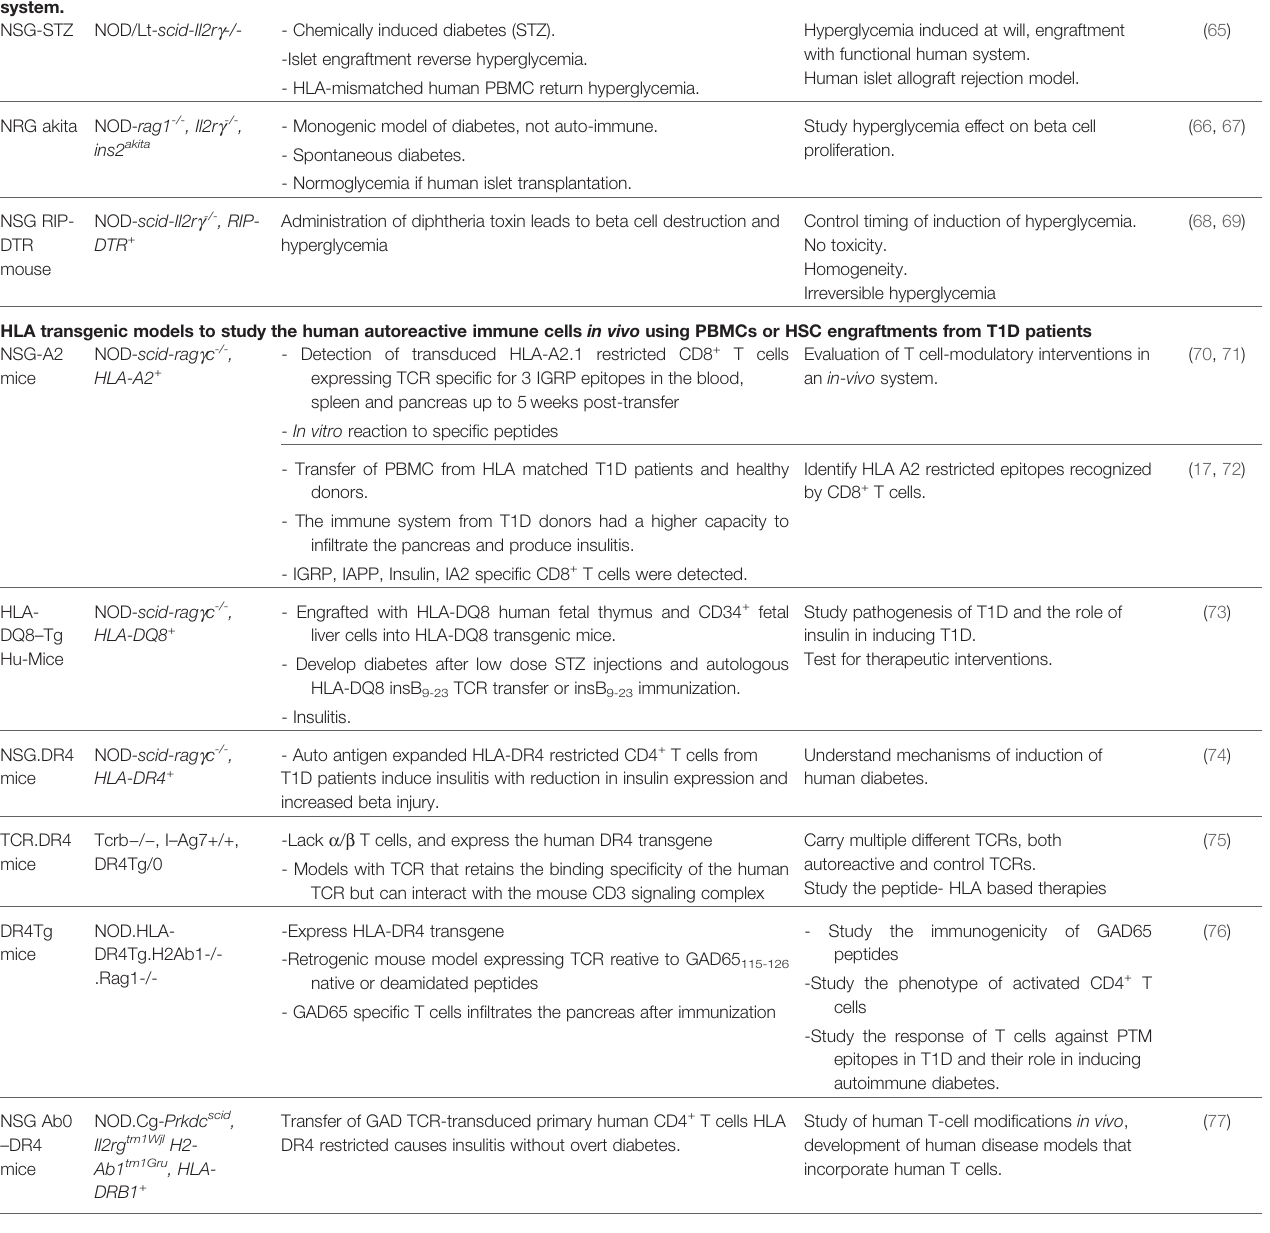
and dissect the role of islet autoantigens in T1D. A mouse model can be engrafted by human or murine stem cells transduced to express autoantigen-speci fi c TCRs to create retrogenic humanized models. The retrogenic mouse model allows to study human selection (82). The retrogenic mouse can express multiple autoreactive or control TCRs to better mimic the physiological setting. In a TCR-transgenic humanized mouse model,